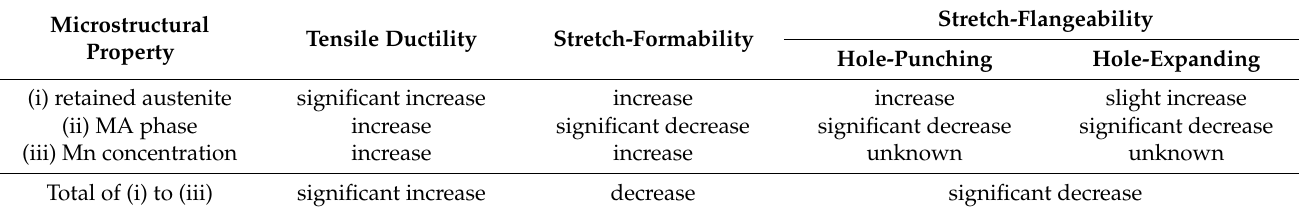
Figure 13. Schematic Mn content dependences of ( a ) Vickers hardness of matrix ( HV m ) and initial volume fraction ( f γ 0 ) and strain-induced transformation factor ( k ) of retained austenite, ( b ) volume fractions of MA phase ( f MA ) and carbide ( f θ ), and ( c ) a ratio of shear section length to sheet thickness ( ss / t ), void density ( N v ) and average void diameter ( D v ) in the steels subjected to the IT process at temperatures of M f + (30 ◦ C to 70 ◦ C). Table 3. Degree of the contribution of microstructural property to formability in the 5Mn steel. Stretch-Flangeability Microstructural Property Tensile Ductility Stretch-Formability Hole-Punching Hole-Expanding